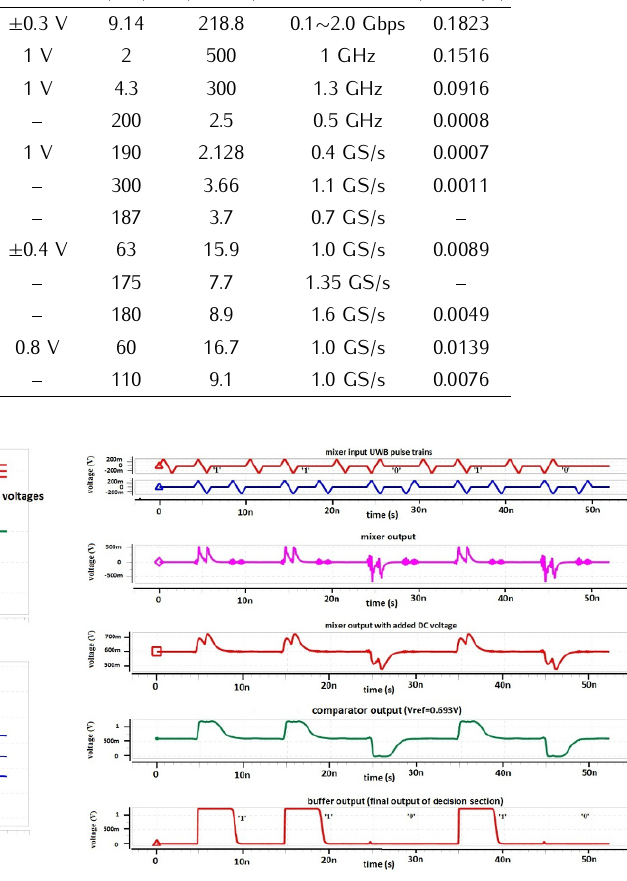
Figure 12. Signals at different stages of the proposed TR-UWB re- ceiver (Frame 1: driving UWB pulse trains, Frame 2–3: mixer output and shift of its dc base, Frame 4–5: re- sponse from decision circuit and output